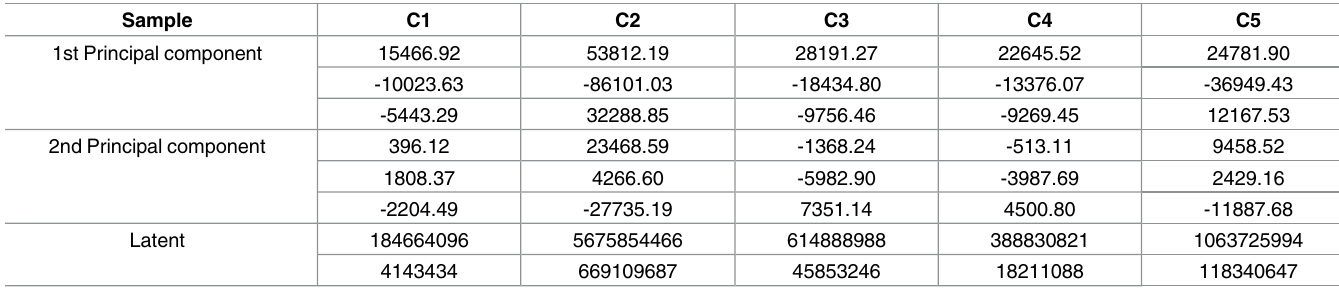
Table 3. Extracted PCA